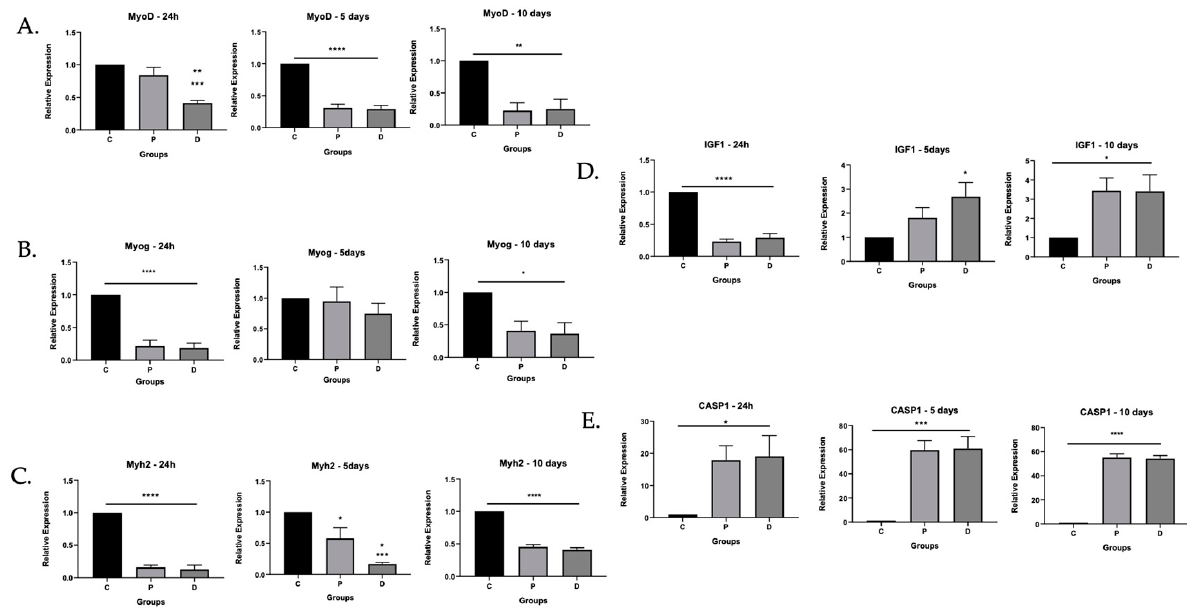
Figure 2. Differential mRNA expression suggested decreased myogenic differentiation and increased inflammatory caspase in ischemic myoblasts. Perfused (N = 2) and ischemic myoblasts (N = 3) were allowed to proliferate for 24 h and to differentiate for 5 or 10 days. RNA was extracted and probed for markers associated with muscle differentiation as well as inflammatory caspase-1. ( A ) MyoD; ( B ) myogenin; ( C ) Myh2; ( D ) IGF1; ( E ) caspase-1; * p < 0.05, ** p < 0.01, *** p < 0.001, **** p < 0.0001.